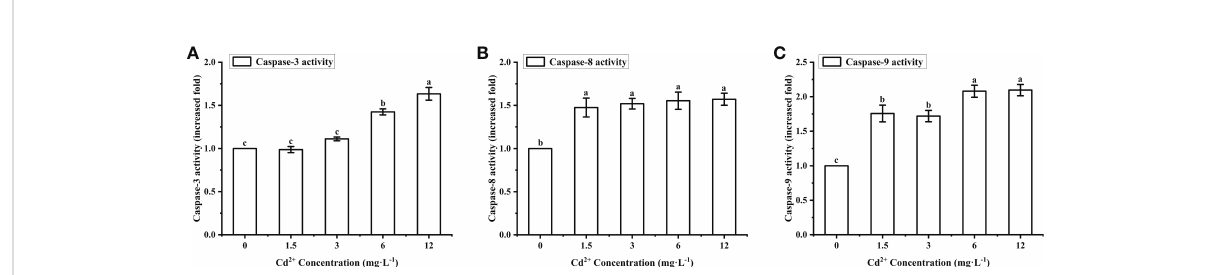
FIGURE 5 Effects of Cd on the activities of caspase-3, caspase-8 and caspase-9 in M. meretrix ovary. (A) Caspase-3; (B) caspase-8; (C) caspase-9. Different letters indicate signi fi cant ( P < 0.05) differences among groups as revealed by Tukey ’ s post-hoc multiple comparison tests; Data are expressed as means ± SE (n =